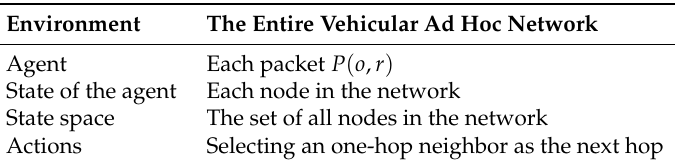
Table 2. Q -learning